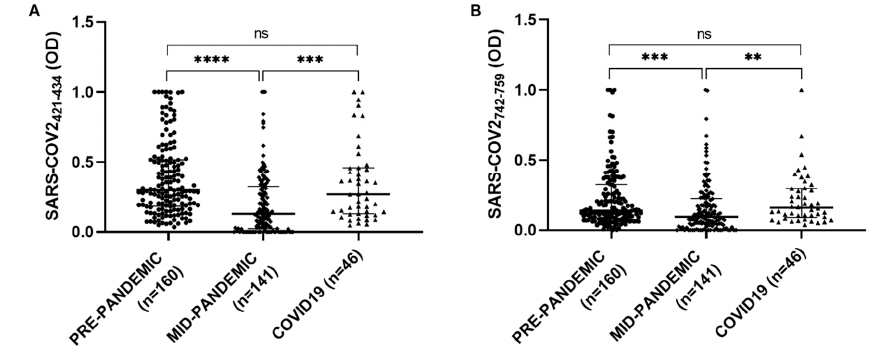
Figure 5. ELISA-based analysis of Abs reactivity against Spike SARS-CoV-2 derived peptides in pre-pandemic, mid-pandemic and COVID19 populations. Plasma samples were tested against COV2-SPIKE 742–759 ( A ) and COV2-SPIKE 421–434 ( B ) peptides. Kruskal–Wallis test was used for the analyses. Scatter plots represent median with interquartile range; p < 0.0001 (****), p < 0.001 (***), p < 0.01 (**).